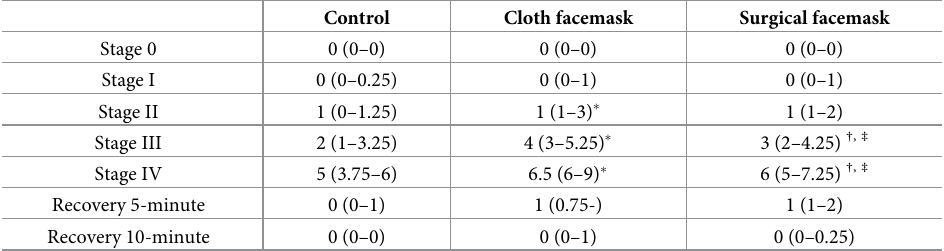
Recovery 10-minute 0 (0–0) 0 (0–1) 0 (0–0.25) Subjects were requested to indicate their RPE levels using a numerical rating scale.